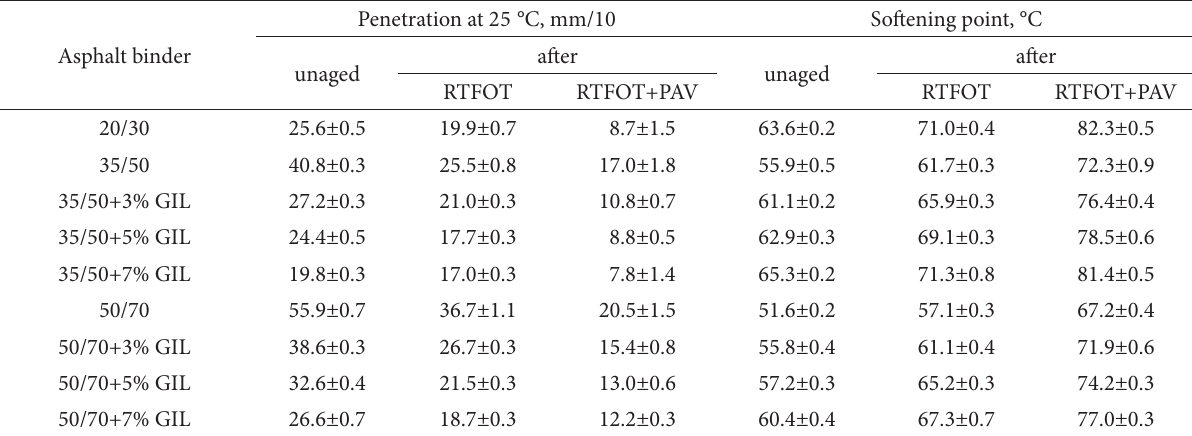
Table 1. The values of penetration and softening point for the Gilsonite modified asphalt binders